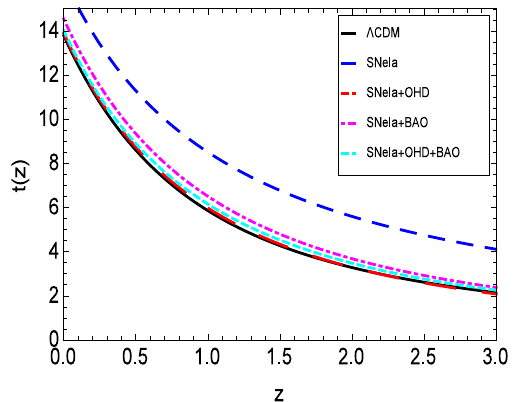
Fig. 11 The trajectory of { r , q } in q − r plane for the best fitted param- eters. The arrow shows the direction of the evolution of the trajectory